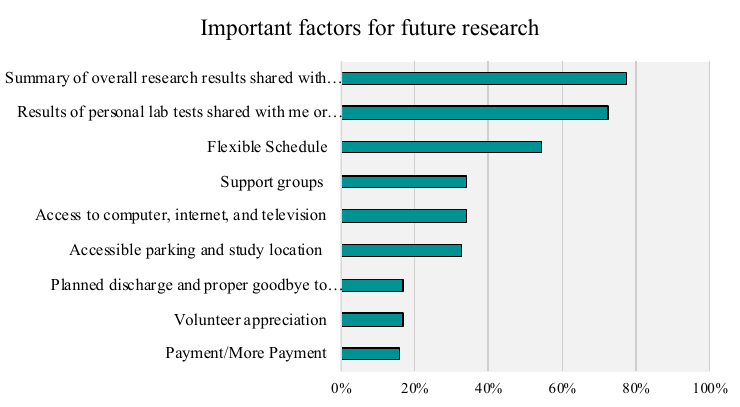
Figure 7. Important Factors for Future Research Participation. Top ‐ Box Answers are Presented (Rankings of 9 and 10).